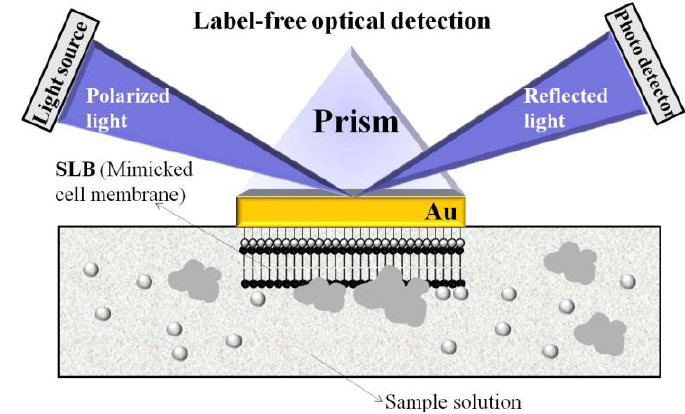
Figure 4. Illustration of biomimetic SLB/SPRS set-up for the observation of membrane behavior. Reprinted with permission from [34], © 2009